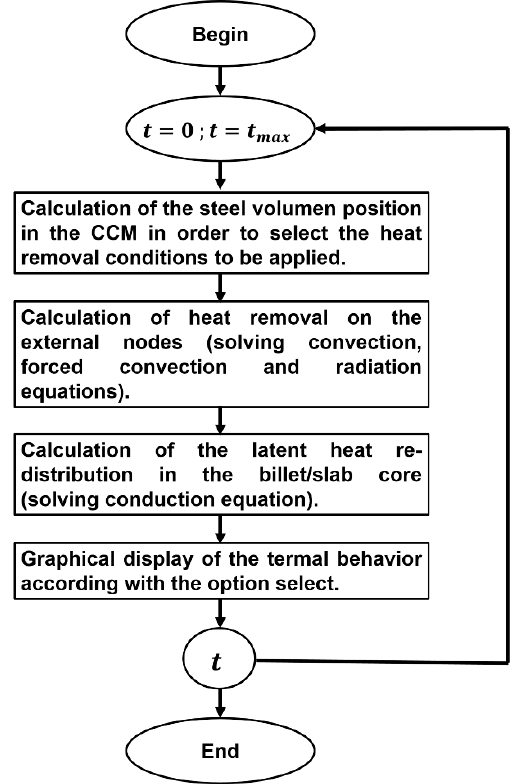
Figure 4. Flow chart of the mathematical model.